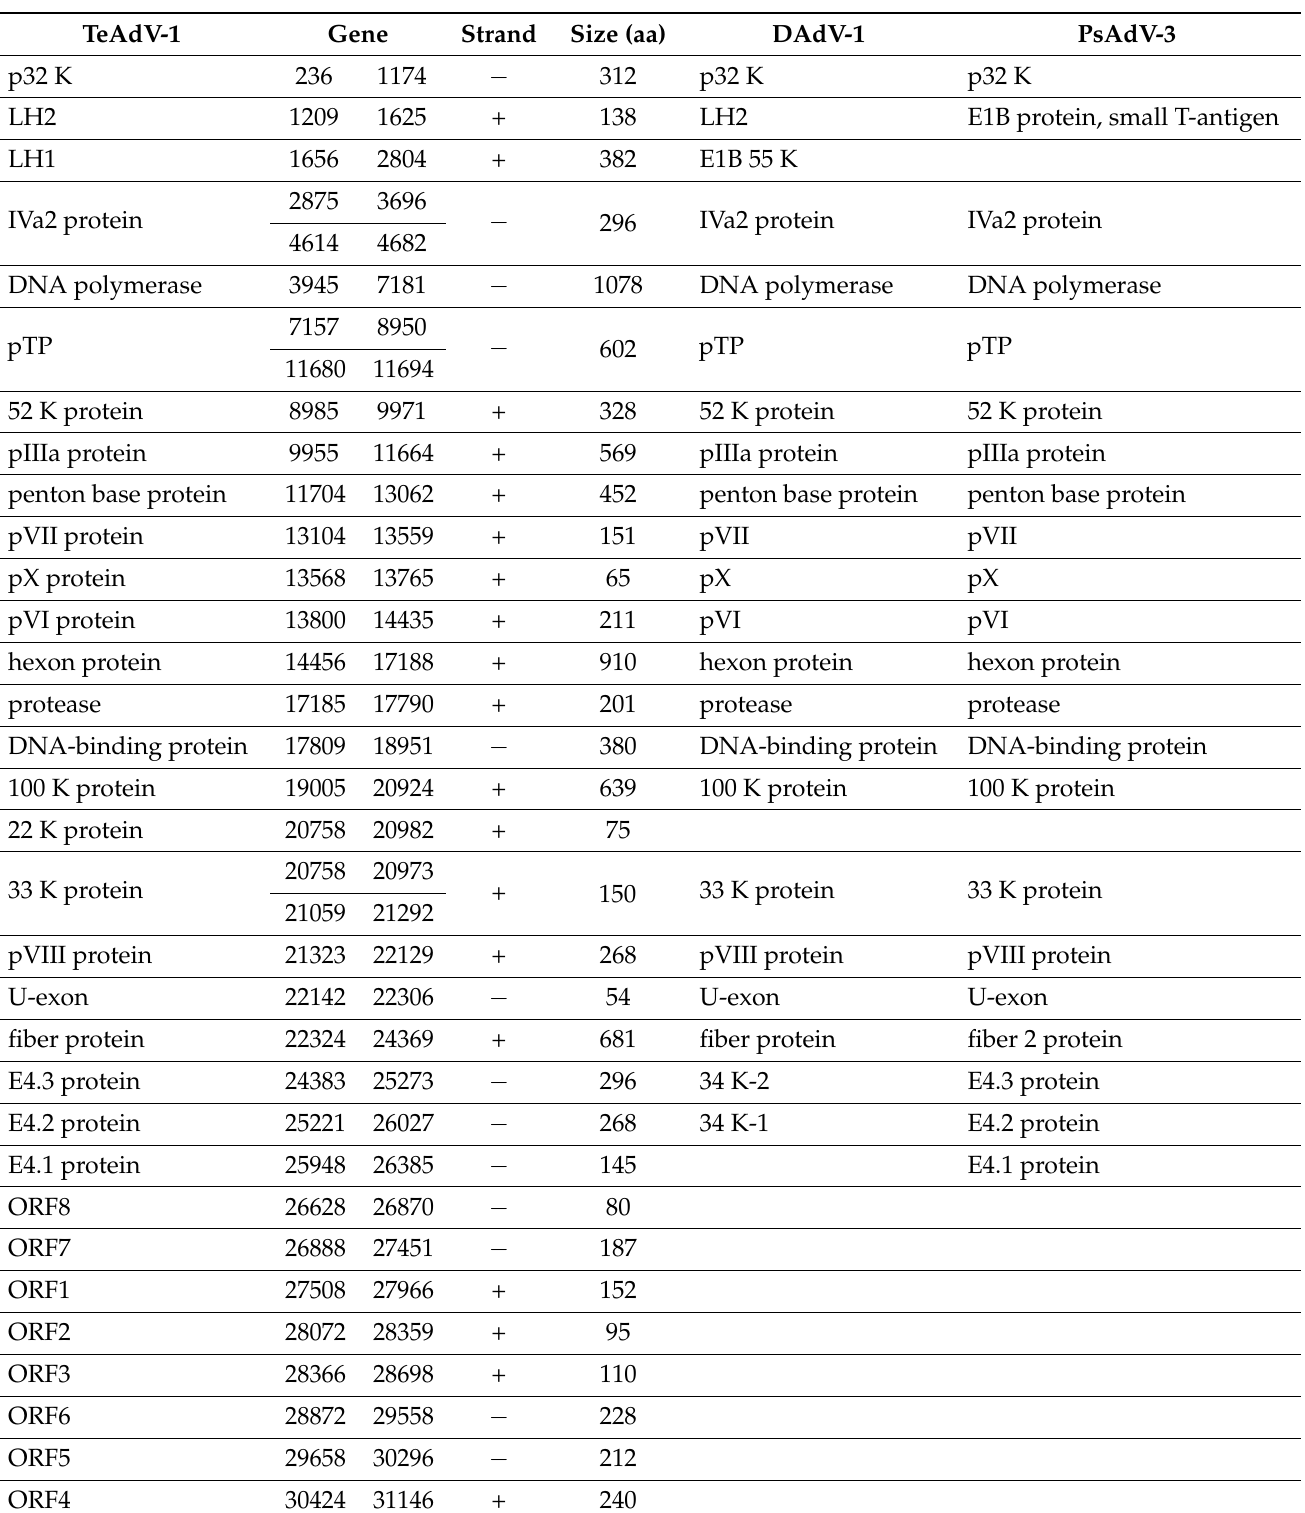
Table 1. Predicted protein-coding genes and methionine-initiated ORFs of TeAdV-1 and syntenic genes of phylogenetically closely related duck adenovirus 1 (DAdV-1) [4] and psittacine adenovirus 3 (PsAdV-3)